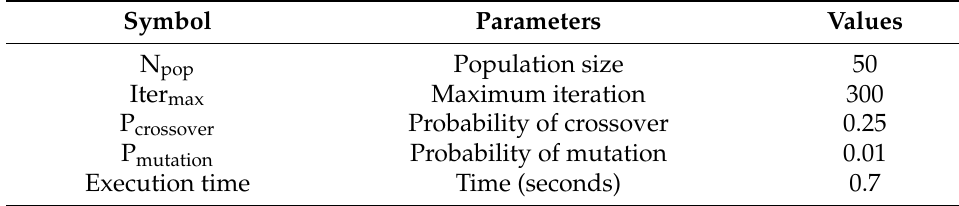
Table 6. Key simulation parameters used for the µ